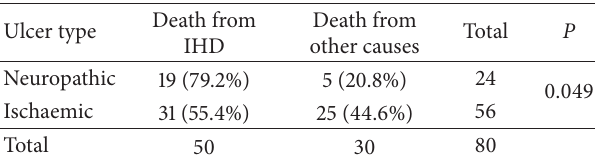
Table 3: Association of ischaemic heart disease with ulcer type on postmortem